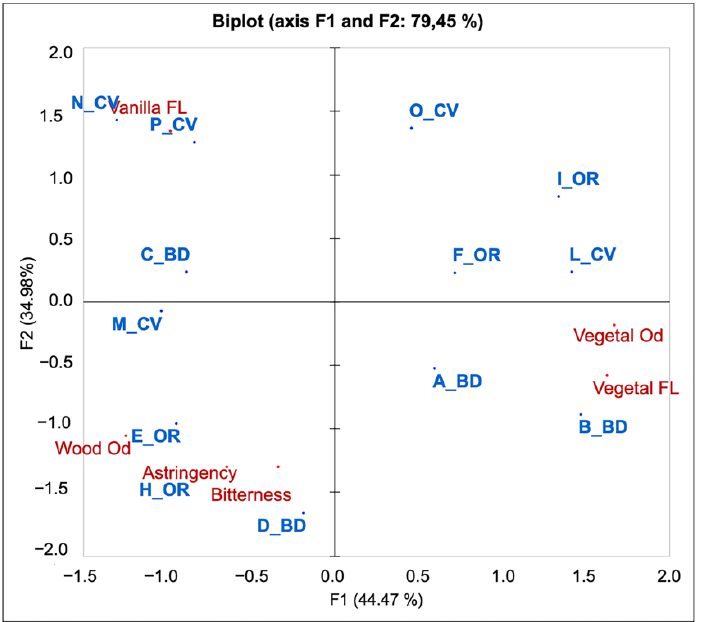
Figure 3. Principal Component Analysis (PCA) of Chianti 2016 wines with the significant sensory variables for the factor “estate management”.